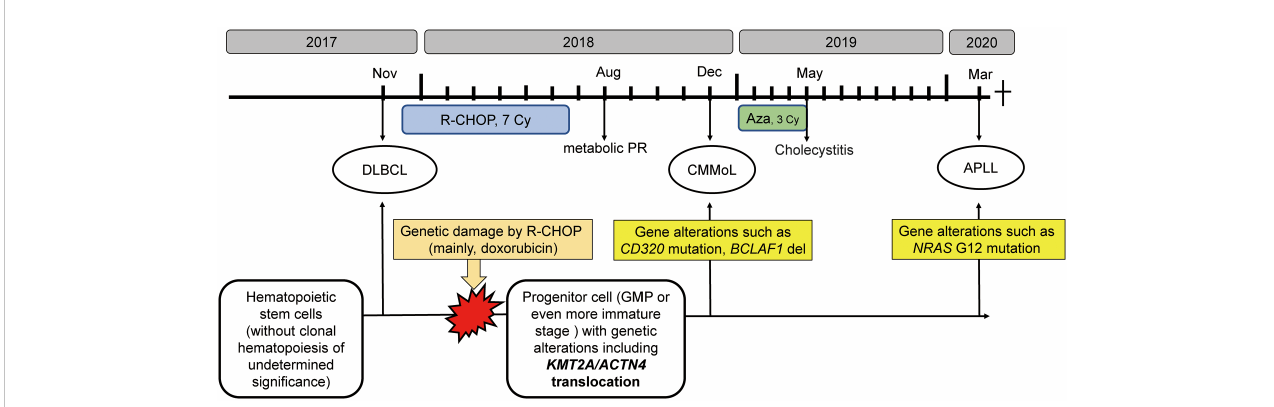
FIGURE 1 The clinical course along with schematic diagram of possible genetic backgrounds of the series of hematological malignancies The R-CHOP therapy might introduce genetic alterations, such as KMT2A translocation in progenitor cells, from which CMMoL and APLL were derived. In addition, acquiring genetic mutation in NRAS resulted in leukemic translation. R-CHOP, rituximab, cyclophosphamide, doxorubicin, vincristine, and prednisolone; Aza, azacitidine; DLBCL, diffuse large B-cell lymphoma; CMMoL, chronic myelomonocytic leukemia; APLL, acute promyelocytic-like leukemia; PR, partial response; GMP, granulocyte/monocyte progenitors.